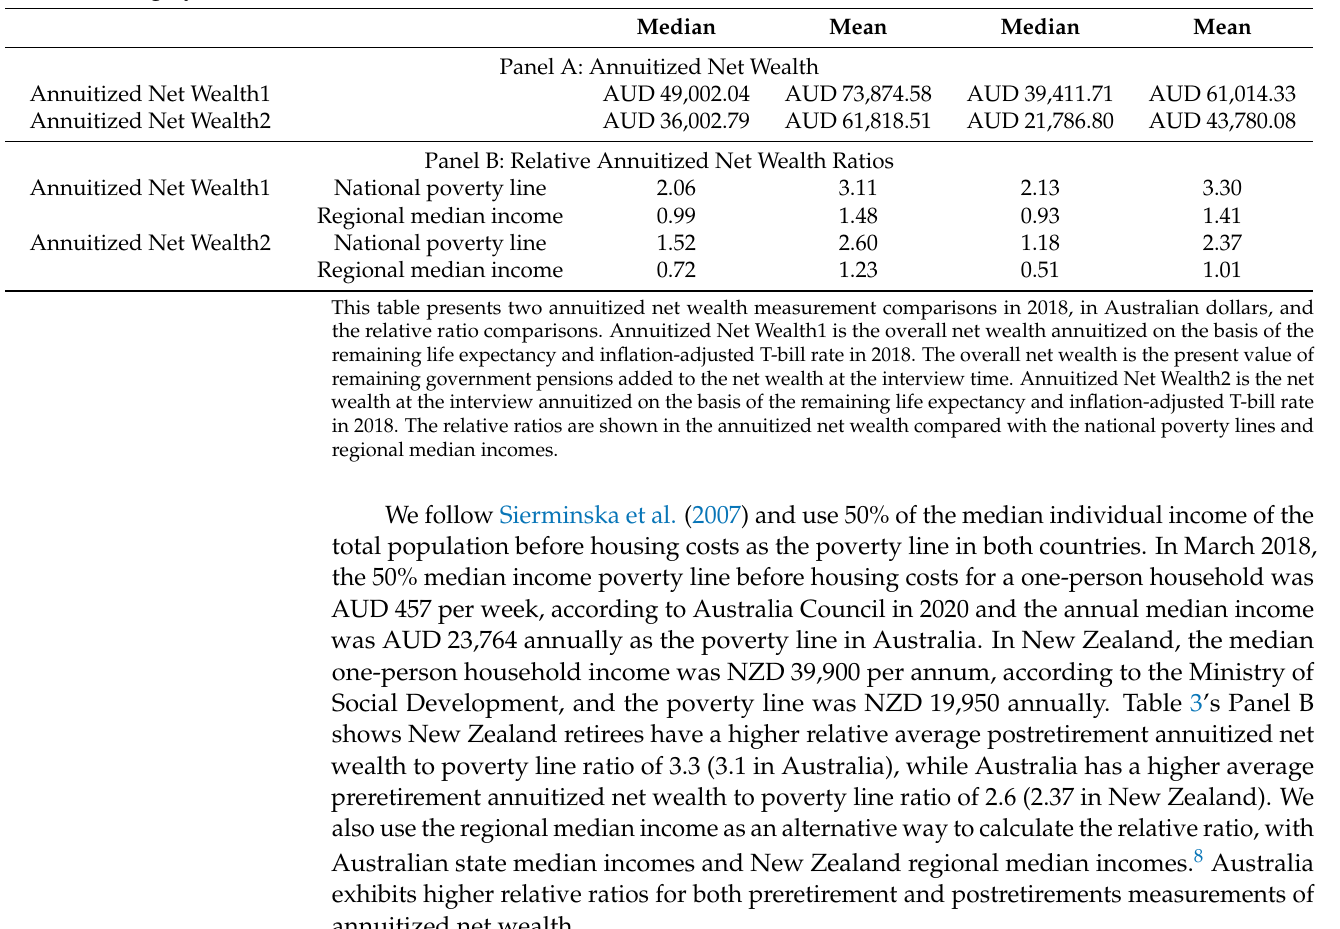
Panel B: Relative Annuitized Net Wealth